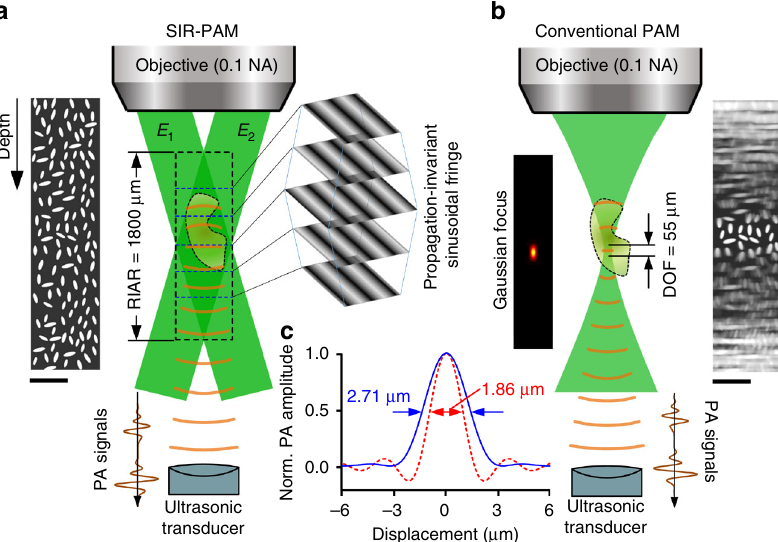
Fig. 1 Principle of motionless SIR-PAM. a Principle of spatially invariant resolution photoacoustic microscopy (SIR-PAM). To achieve spatially invariant resolution volumetric imaging, SIR-PAM uses PISFs to stimulate PA signals within an object and extract its Fourier spectra, and uses an ultrasonic transducer to resolve the depth of the PA signals. b Principle of conventional PAM. A focused Gaussian beam is utilized in conventional PAM to stimulate PA signals, restricting its DOF. Besides, conventional PAM uses raster scanning to realize volumetric imaging. An object with uniformly distributed microparticles was simulated to compare the image qualities of two methods. c PSFs of SIR-PAM ( red curve ) and conventional PAM ( blue curve ), which indicate that SIR-PAM achieves 1.5 times fi ner lateral resolution than conventional PAM. Scale bars , 100 µ